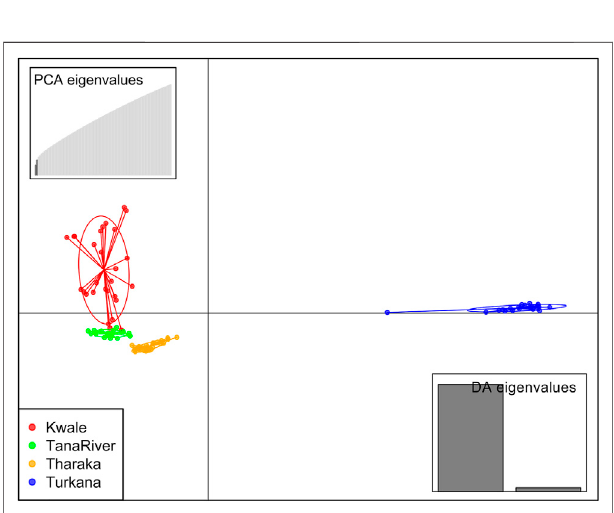
FIGURE 4 | Discriminant analysis of principal components (DAPC) of 96 Hyphaene compressa Kenyan accessions using 23,416 SNPs derived from GBS analysis using reference-based assembly. Inertia ellipses represent clusters in different colors. Each dot on the circle represents an